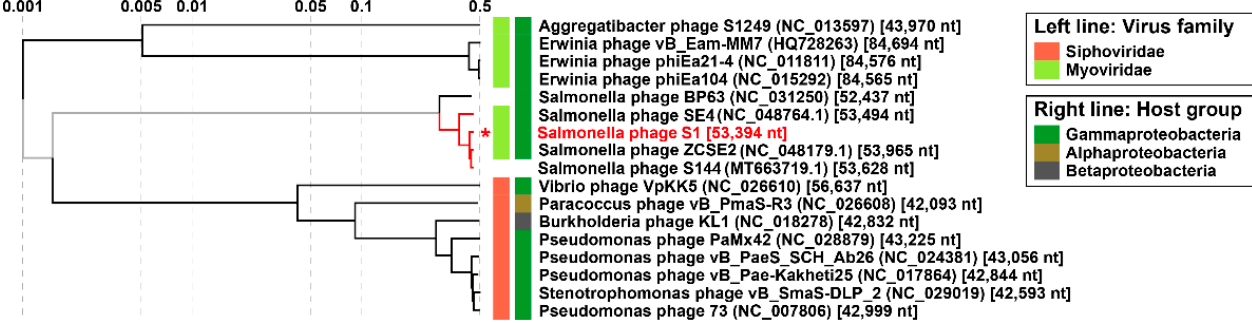
Figure 2. Phylogenetic tree. Phylogenetic analyses constructed by full viral protein alignment of the closest relatives phage sequences on ViPTree database and new phages from the genus Loughboroughvirus . Red lines indicated phages from genus Loughboroughvirus . And a red asterisk indicates where the phage S1 is positioned inside of the tree for easy visualization.